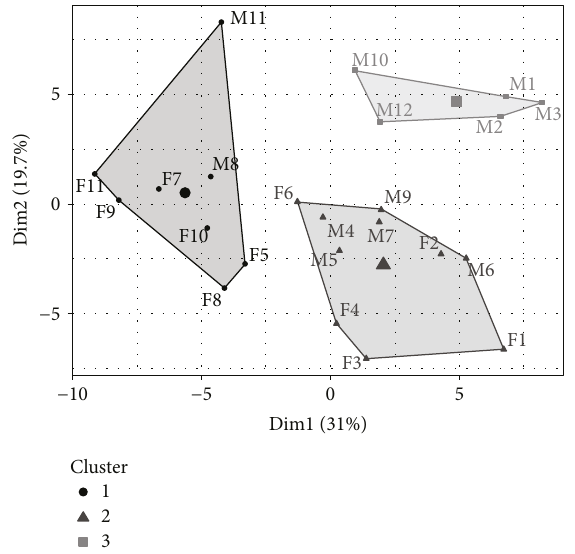
Figure 1: Plasma-derived cluster plot of 12 male and 11 female NZO mice to identify groups. HCPC provided three distinct clusters. Clusters 1 and 2 contain female and male NZO mice whereas cluster 3 includes solely male NZO mice. The clustering is based on the input of 78 measured metabolites comprising 43 ACs and 35 AAs. Gender is marked with M (male) and F